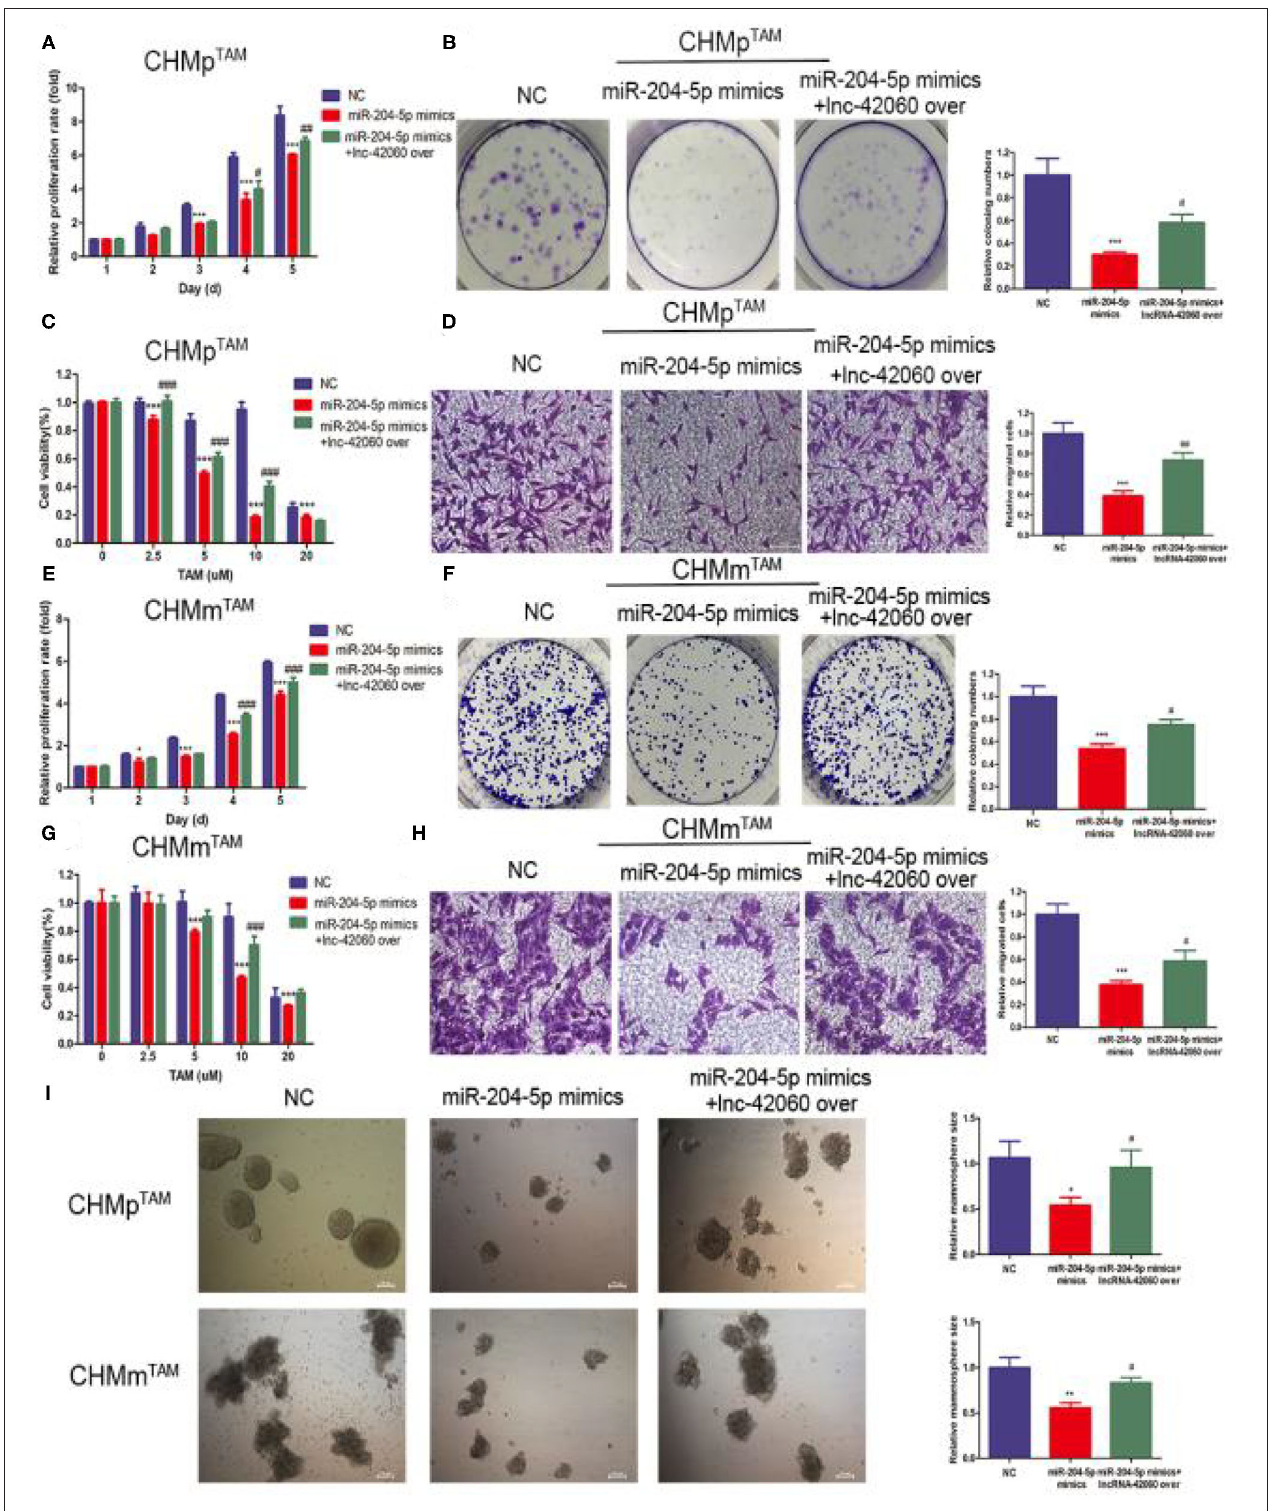
FIGURE 6 | lnc-42060 sponges miR-204-5p to regulate cell proliferation, migration and increased TAMR in TAMRs. (A,E) CCK8 assay was conducted to evaluate cell proliferative ability in TAMRs. (B,F) Colony formation is shown in TAMRs. (C,G) CCK8 assay shows the variation in TAM sensitivity in TAMRs. (D,H) Transwell migration was conducted to evaluate cell migration ability (magnification, 200 × ) in TAMRs. (I) Microemulsion size in TAMRs (magnification, 200 × ). Data are presented as means ± SD of at least three independent experiments. Compared with control group, * P < 0.05, ** P < 0.01, *** P < 0.001; compared with miR-204 group, # P < 0.05, ## P < 0.01, ### P <